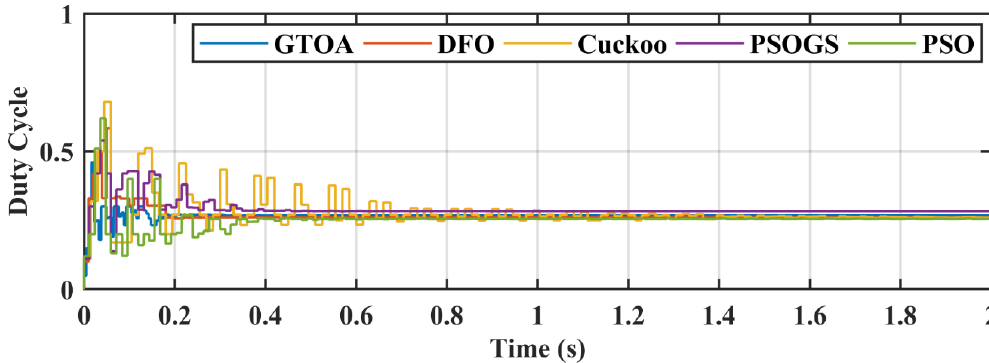
Electronics 2020 , 9 , x FOR PEER REVIEW Figure 23. Comparison of duty cycle of GTOA. Figure 23. Comparison of duty cycle of GTOA.